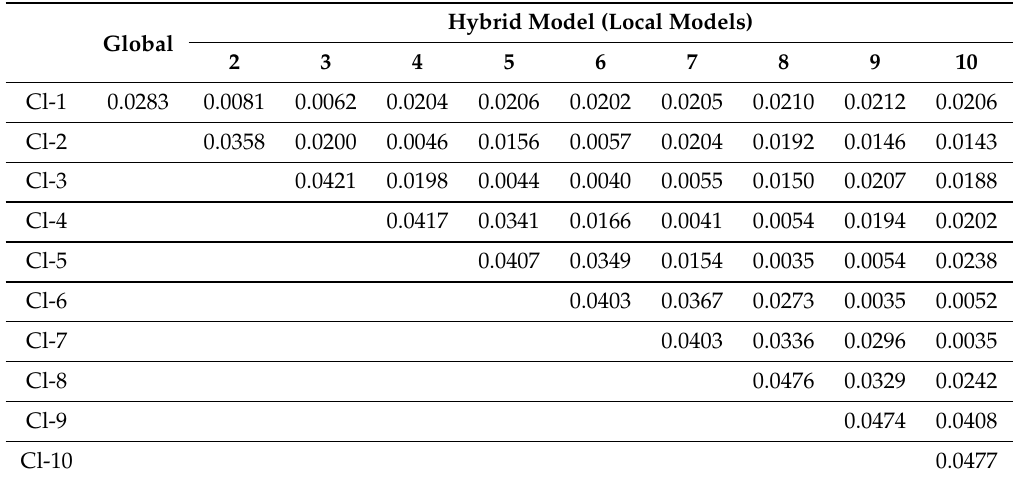
Table 4. MAE for the least square support vector regression (LS-SVR) regression algorithm.